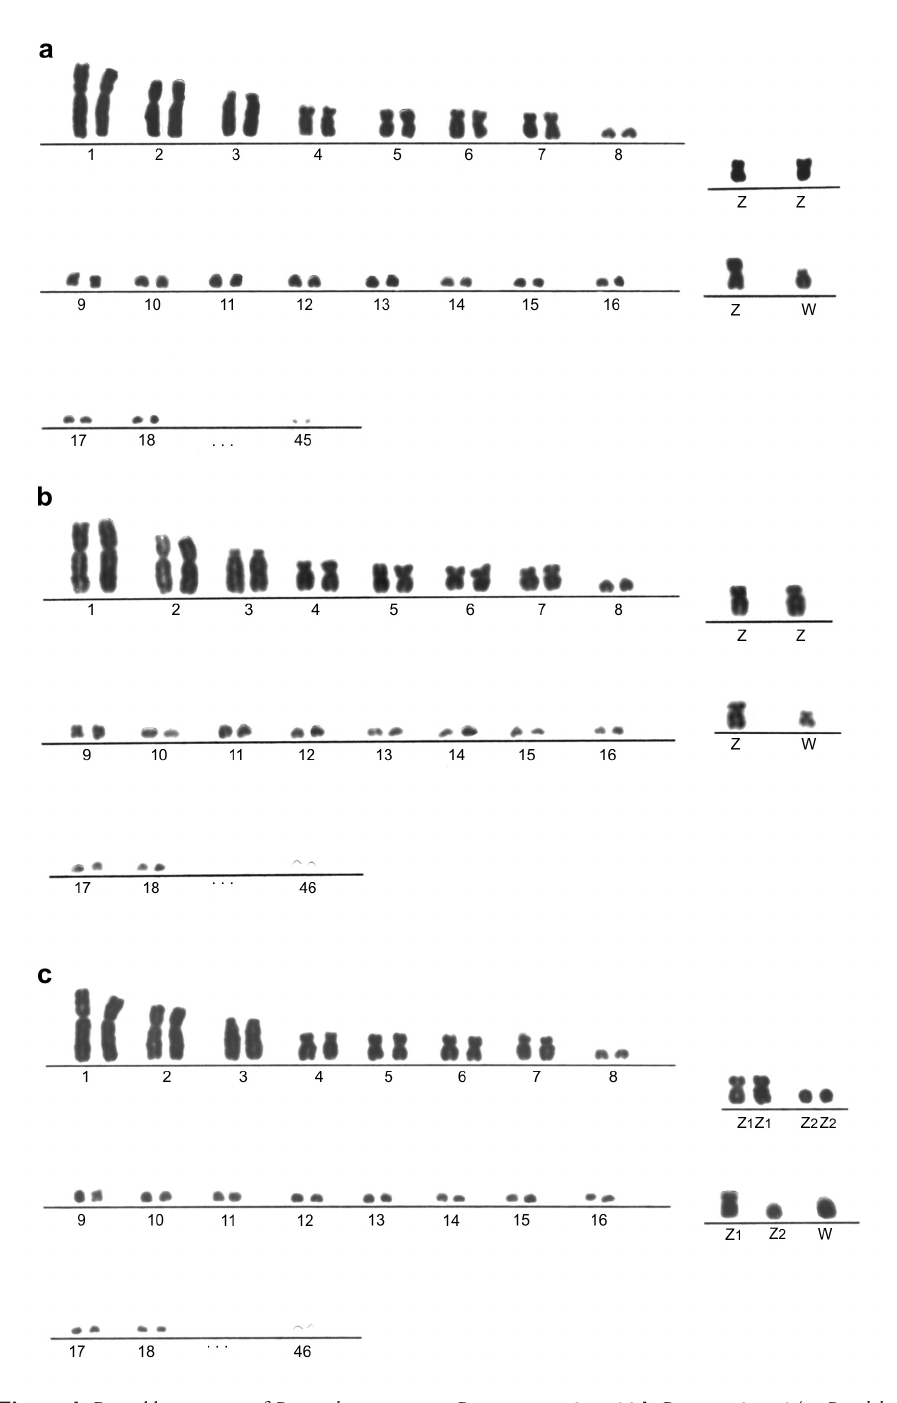
Figure 1. Partial karyotypes of Pygoscelis penguins a P . antarcticus 2n = 92 b P . papua 2n = 94 c P . adeliae 2n = 96 in males and 2n = 95 in